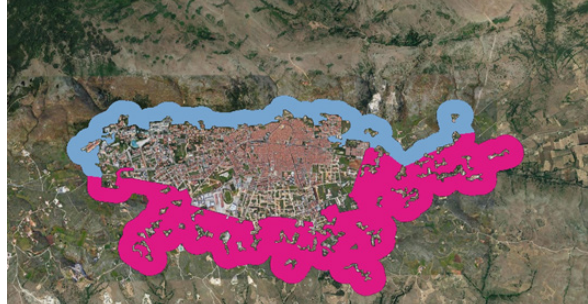
Figure 8 . Two types of contact defined by the value 2 (blue) and 4 (indigo). For labelling, please refer to the guidelines (Apulia Region, 2022).